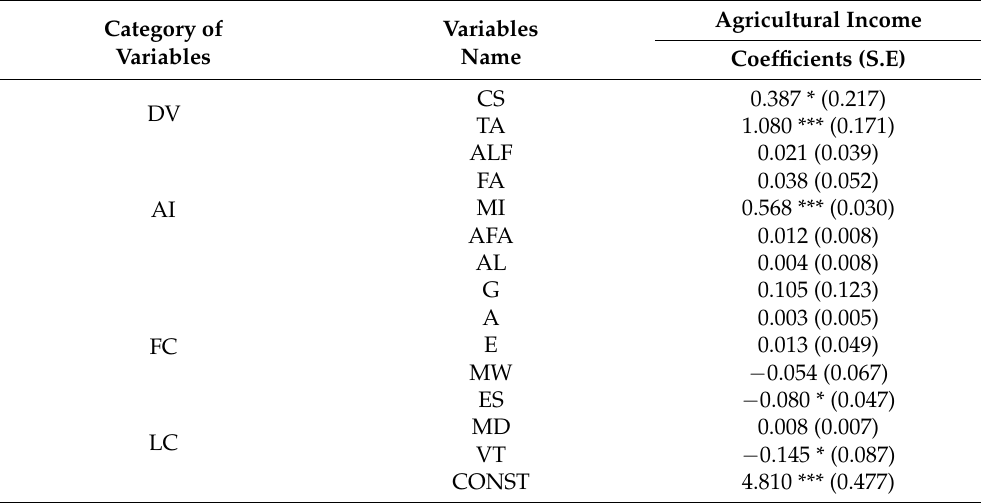
Table 5. The second step-regression outcomes of the full-sample